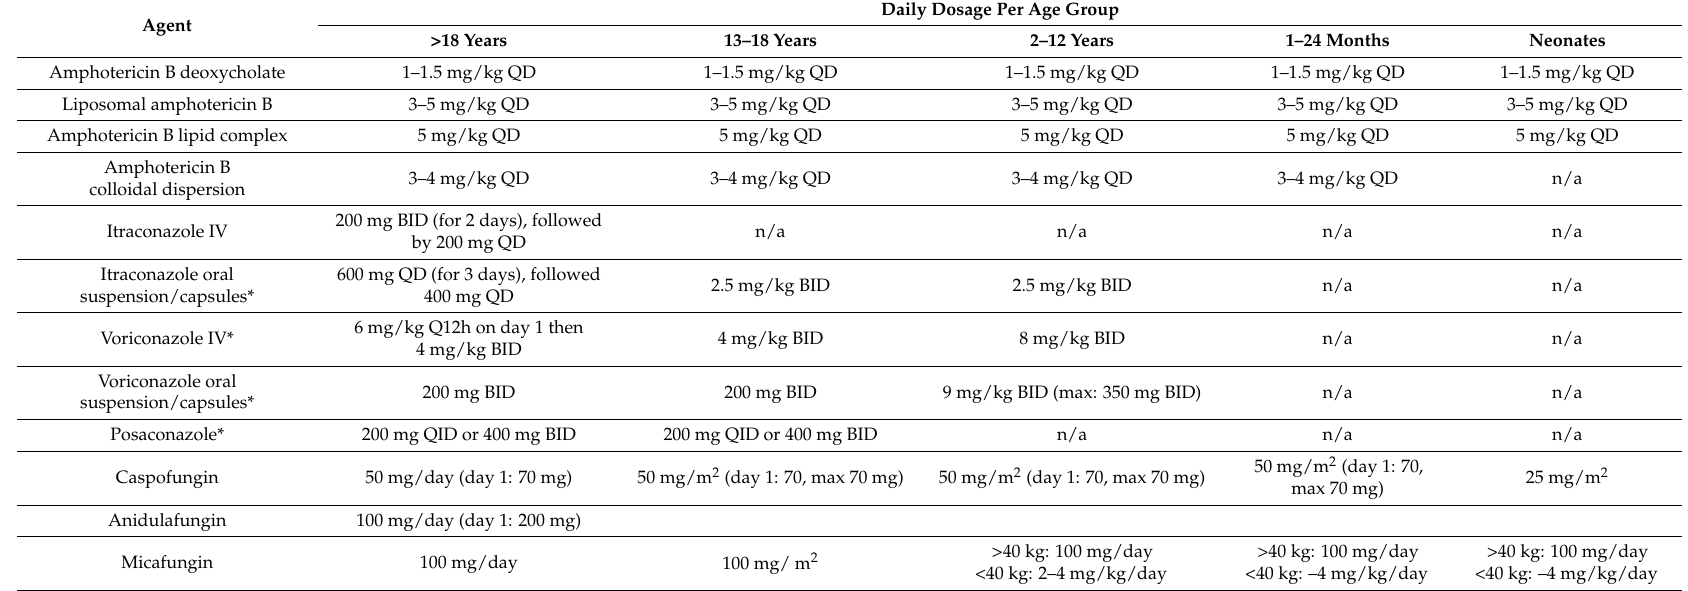
Table 1. Pediatric doses of systemic antifungal